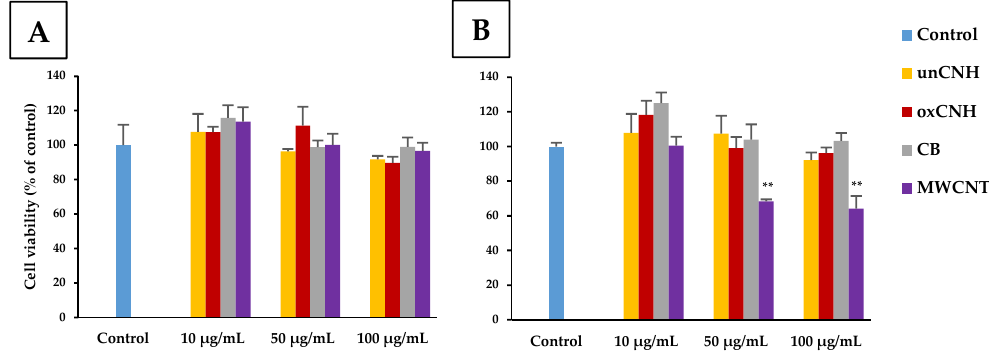
Figure 2. Cell viability of HLEC exposed to varieties of carbon nanomaterials. ( A ) The cell viability was measured for 24 h. ( B ) The cell viability was measured for 48 h. Data are expressed as the mean ± S.E. ( n = 4). ** p < 0.01. HLEC, human lymphatic endothelial cell; unCNH, untreated carbon nanohorn; oxCNH, oxidized carbon nanohorn; CB, carbon black; MWCNT, multi-walled carbon